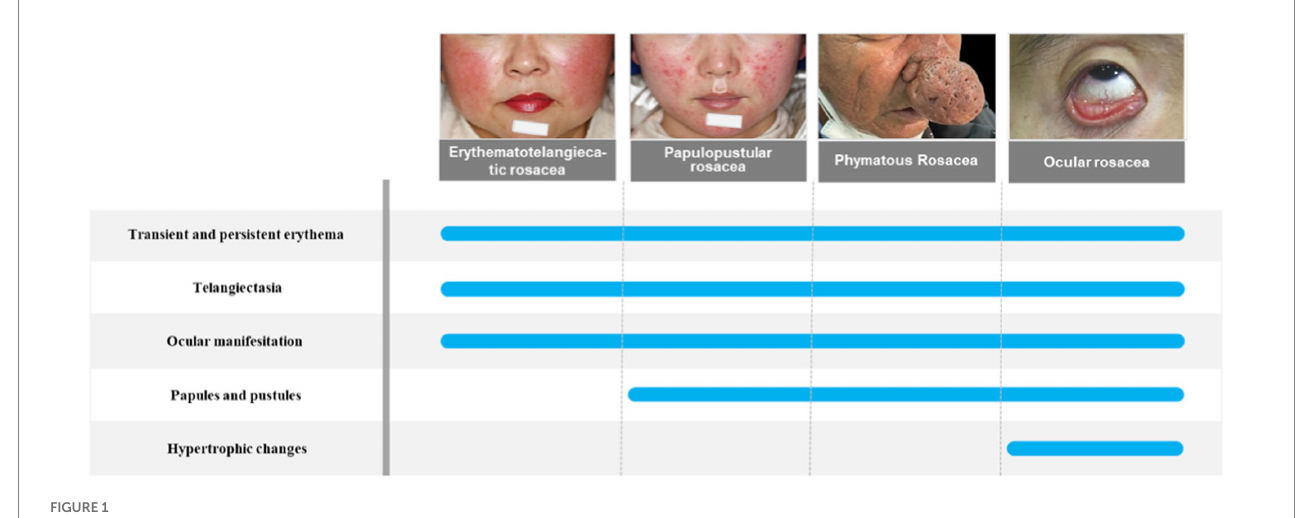
FIGURE 1 The classification of